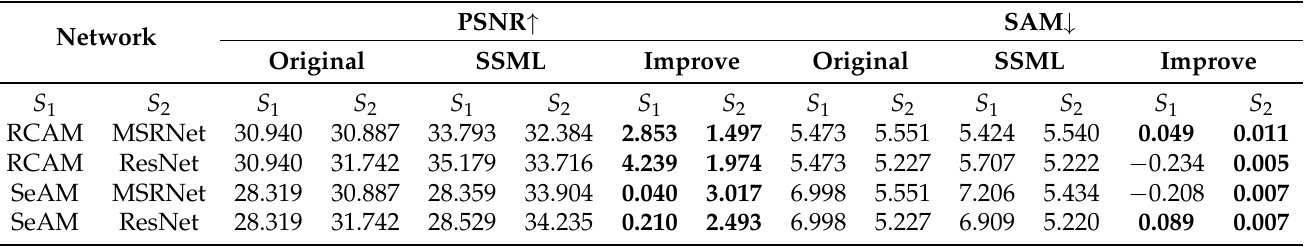
Table 4. Comparison results of the SSML for different deep networks on the Pavia Center